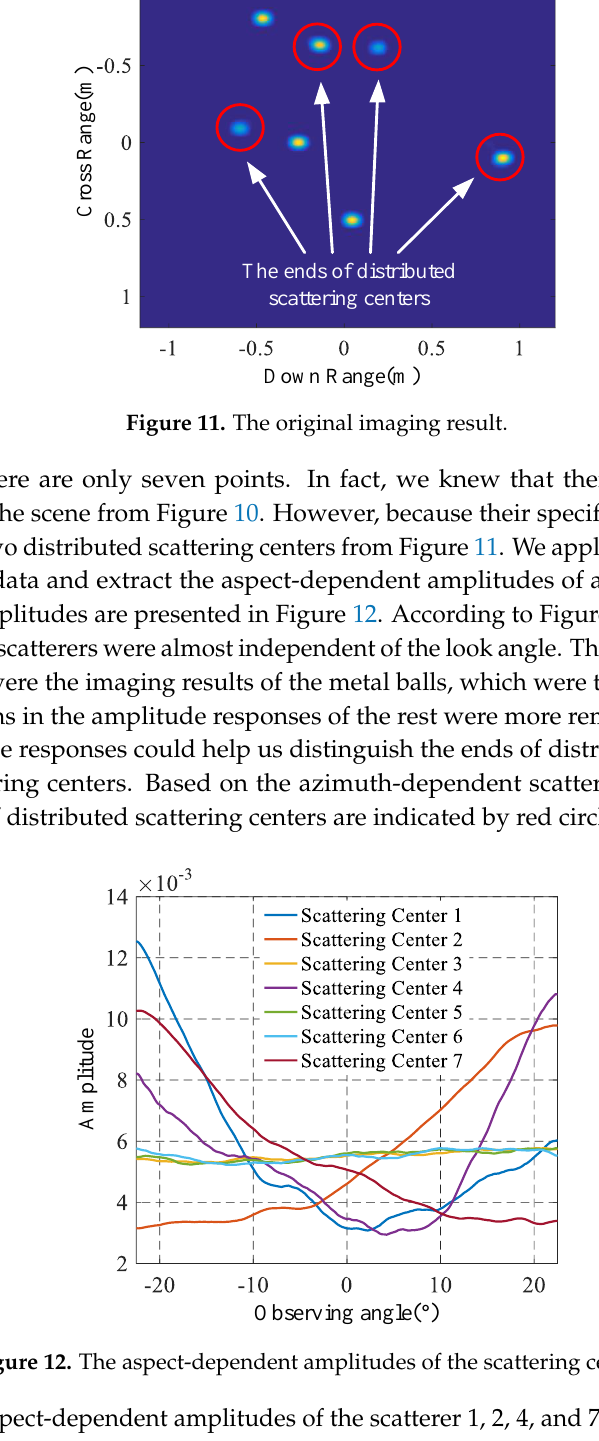
Figure 10. The imaging scene.